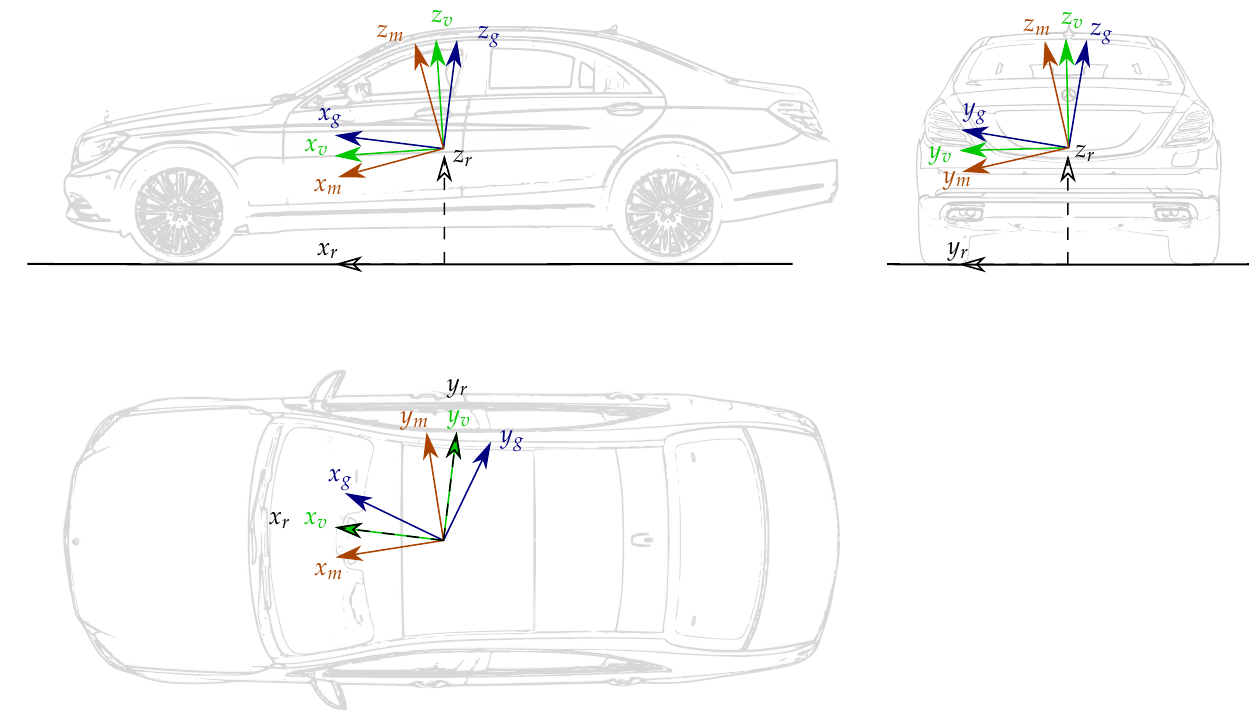
Figure 3. Representation of the ground-truth ( g ), IMU ( m ), vehicle ( v ) and road ( r ) coordinate systems. Please note that the origin of the ground-truth and IMU coordinate systems is not necessarily coincident with that of the vehicle coordinate system. This representation has been chosen to highlight the misalignment between the different coordinate